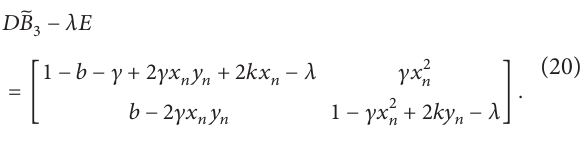
and its eigenmatrix is Figure 9 the box-counting dimensions of the controlled Julia sets are computed in this control